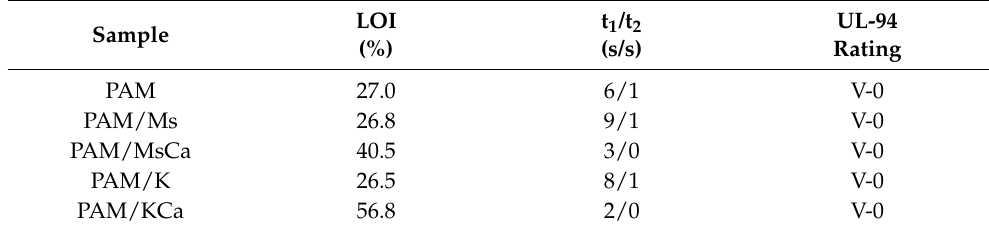
Table 3. LOI and UL-94 rating of the different PAM composite